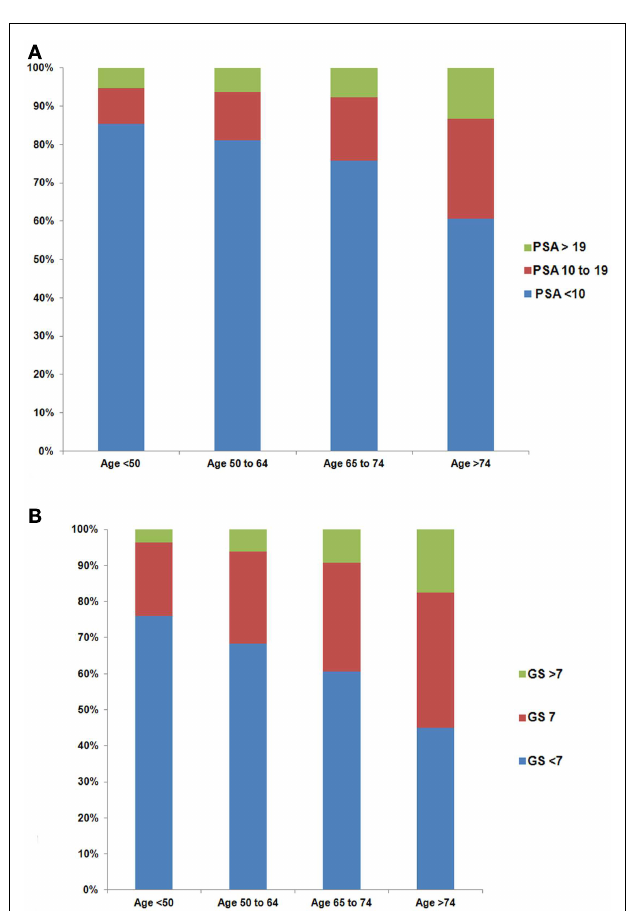
FIGURE 1 | Distribution of PSA (A) and Gleason Score (GS) (B) by age group among men with stageT1cN0M0 prostate cancer .The difference in the distribution of PSA ( p < 0.01) and GS ( p < 0.01) among age groups was evaluated with the two-sided Chi-square test.